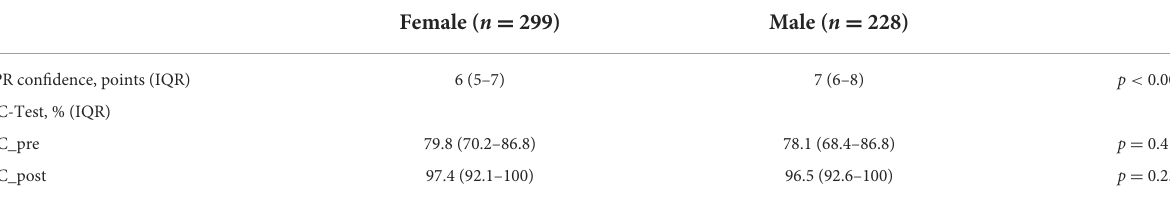
TABLE 3 Gender differences in the self-reported confidence in performing a sufficient resuscitation, as well as in MC_pre and MC_post results.